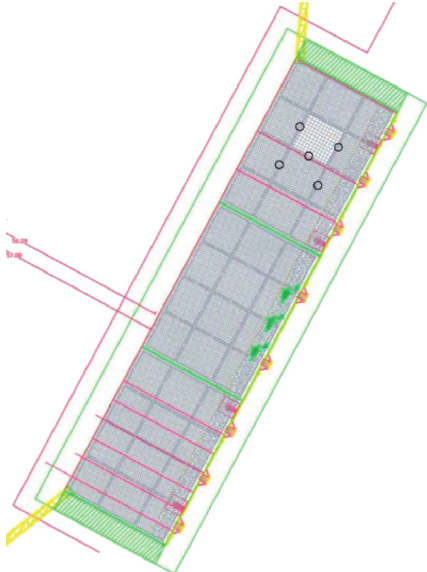
Figure 24: Plan of the first-stage